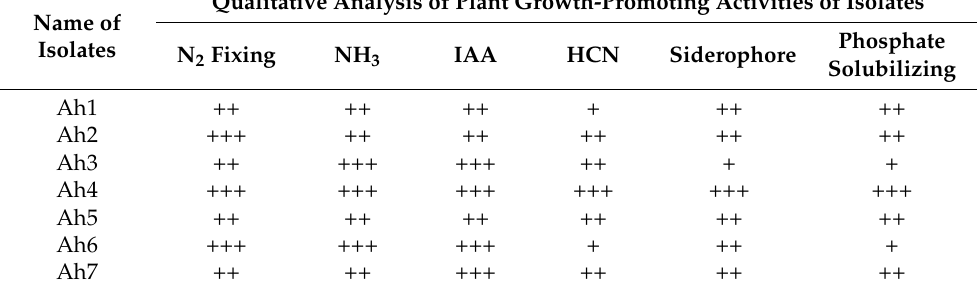
Table 1. Plant growth-promoting activities of test isolates: qualitative